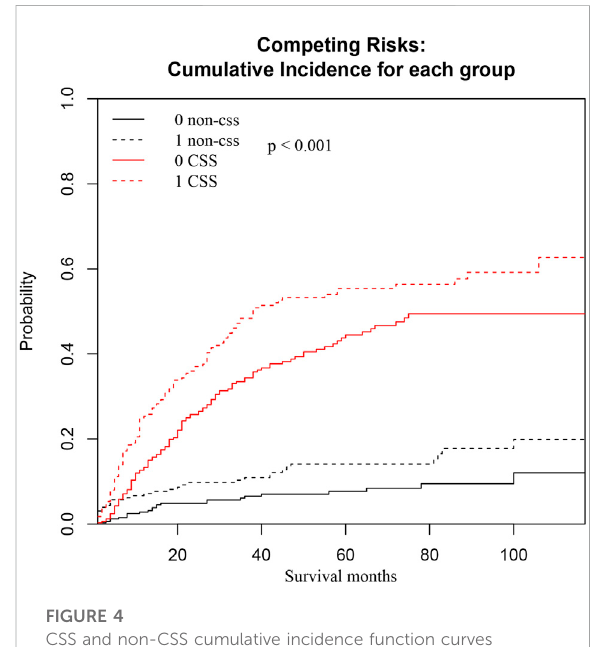
FIGURE 4 CSS and non-CSS cumulative incidence function curves based on the age groups. The black line represents non-cancer- speci fi c death, the black dashed line represents elderly patients, the black solid line represents young patients, and the black dashed line above the black solid line represents the non-cancer- speci fi c death rate of elderly patients with prolongation of survival time. The probability is higher than that of younger patients. The red line represents cancer-speci fi c death, the red dashed line represents elderly patients, the red solid line represents younger patients,andthereddashedlineabovetheredsolidlinerepresents that as the survival time increases, the probability of cancer- speci fi c death in elderly patients is higher than that in younger